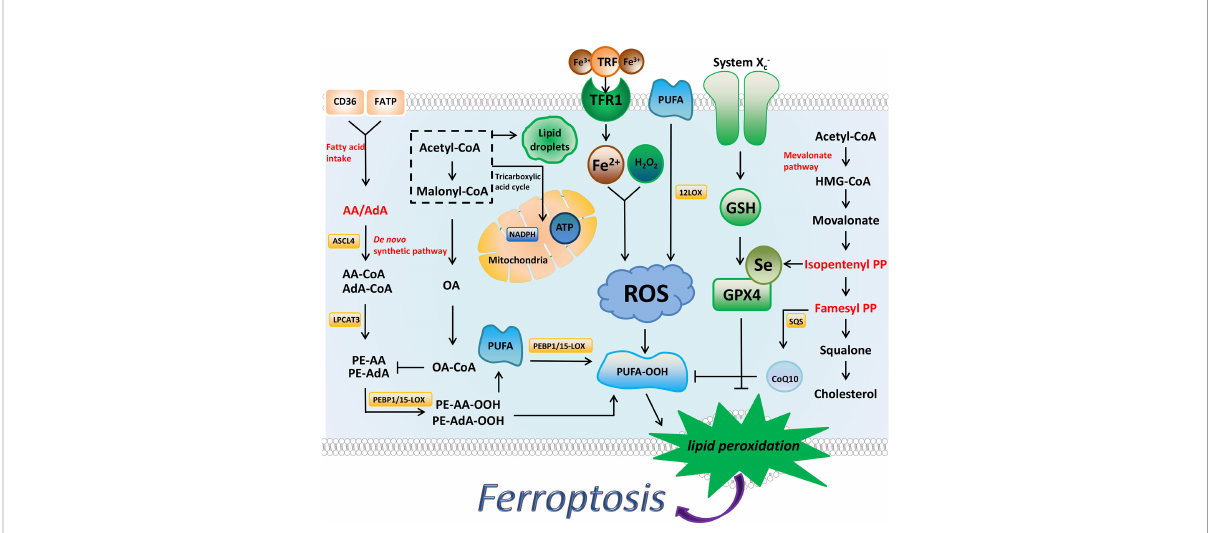
FIGURE 1 The regulatory substances and mechanisms of ferroptosis. Ferroptosis is driven by the accumulation of lipid peroxides. Iron metabolism, PUFA synthesis, and peroxidation promote the production of PUFA peroxides. AA and AdA are the key substances in the synthesis of PUFA. MUFA (such as OA) and Lipid droplets inhibit ferroptosis to a certain extent by affecting the synthesis of PUFA. NADPH has been shown to prevent lipid damage and counteract ferroptosis. System X c- /GSH/GPX4 axis and FSP1/DHODH/CoQ10 axis can inhibit ferroptosis through antioxidant effects. The synthesis process of cholesterol is closely related to these two antioxidant axes, and IPP and FPP are the key